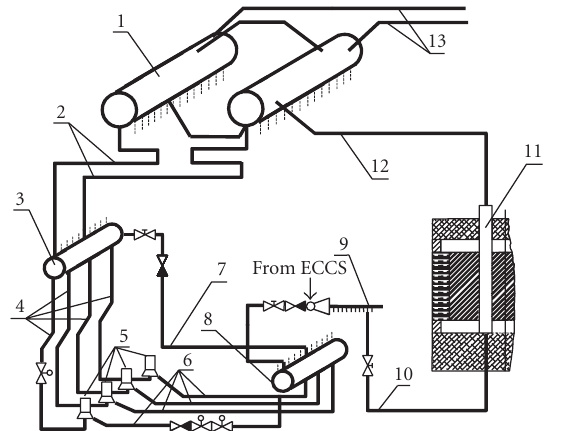
Figure 1: Schematic representation of one loop of the RBMK-1500 MCC: 1-DS, 2-downcomers, 3-MCPs suction header, 4-MCP suc- tion piping, 5-MCPs, 6-MCP discharge piping, 7-bypass line, 8- MCPs pressure header, 9-GDHs, 10-lower water communication line, 11-FC, 12-steam-water communication line, 13-steam lines.